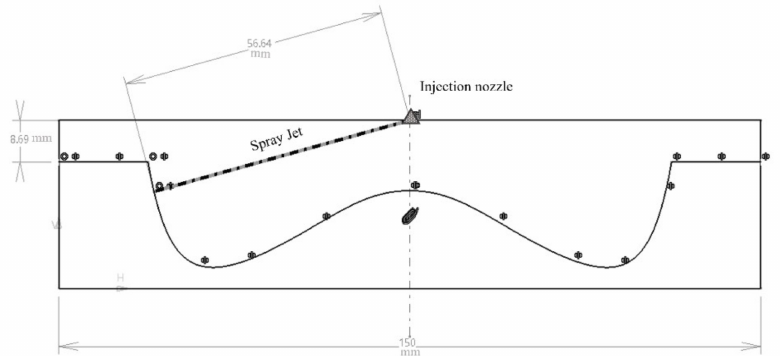
Figure 2. Sketch of impinging distance.